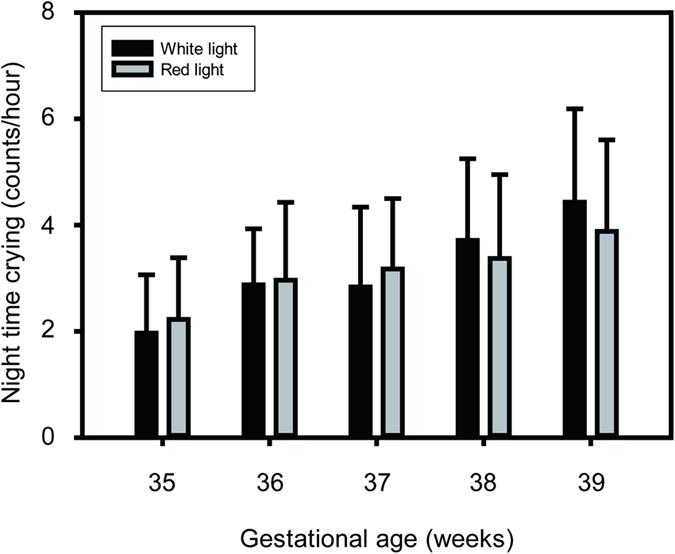
Nighttime crying over consecutive 7-day periods, at 35, 36, 37, 38, and 39 weeks of gestational age (WGA).Dark bars: control infants exposed to white LED light during night; gray bars: experimental group infants exposed to red LED light during night (mean ± s.d.). Observe that exposure to white or red LED lighting results in similar night crying counts over each range of days.